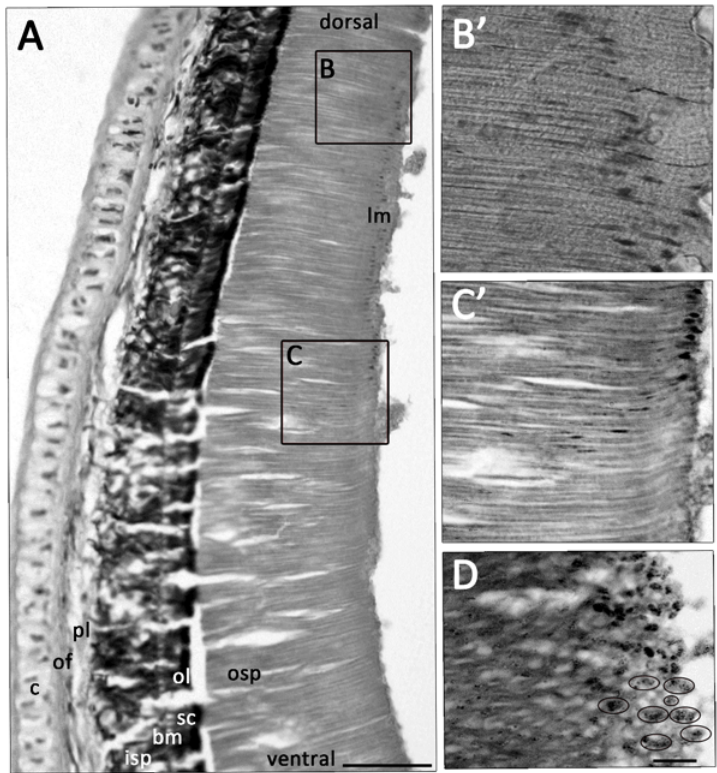
equatorial (C) regions and representative areas are shown in high magnification (B ’ , C ’ ). (D) Oblique section through outer photoreceptor segment shows that migrated ommin pigment is located between photoreceptor cells; black circles indicate areas of clustered pigment granules. Abbreviations: rudimentary cartilage (c). All other abbreviations as in Fig 2. Scale bars = (A) 100 μ m, (B ’– D) = 10 μ